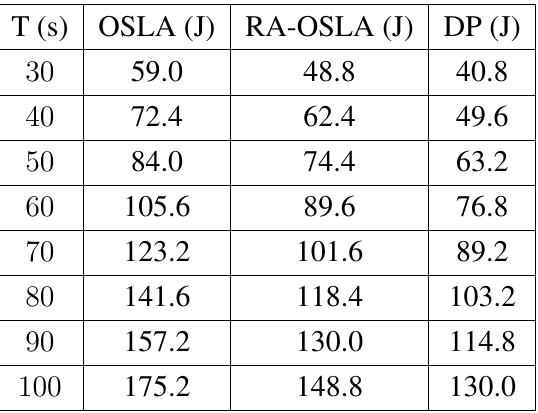
obtained by OSLA, RA-OSLA and DP for T